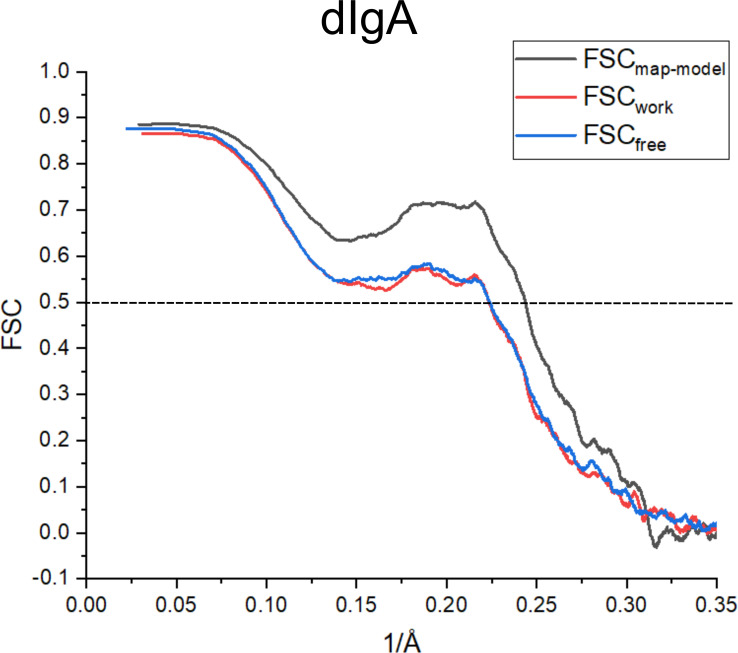
dIgA cross-validation FSC curves.The FSC curve generated between the final structure and CryoEM map including all data (FSCmap-model) is shown in black and indicates agreement between the map and final model. FSCwork (red) is the FSC curve generated between the final structure refined against half the data (half map 1) and half map 1. FSCfree (blue) is the FSC curve generated between the final structure refined against half map 1 and the other half of the data (half map 2), not used in refinement calculations. Close agreement between, FSCwork and FSCfree indicate that the model has not been overfit to the map.